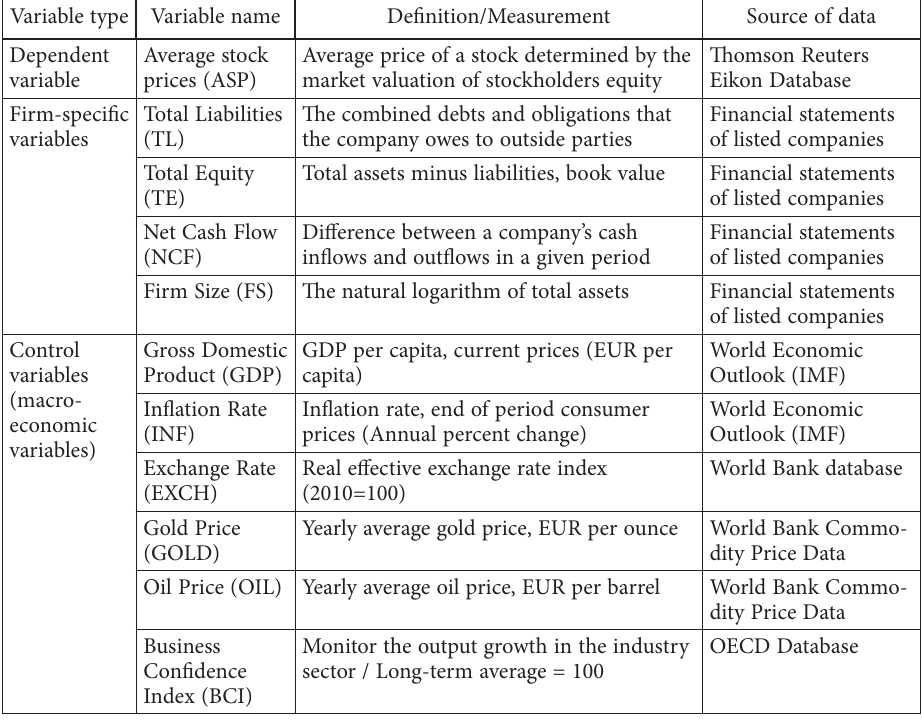
Table 1. Definition and measurement of study variables and data sources (source: authors’